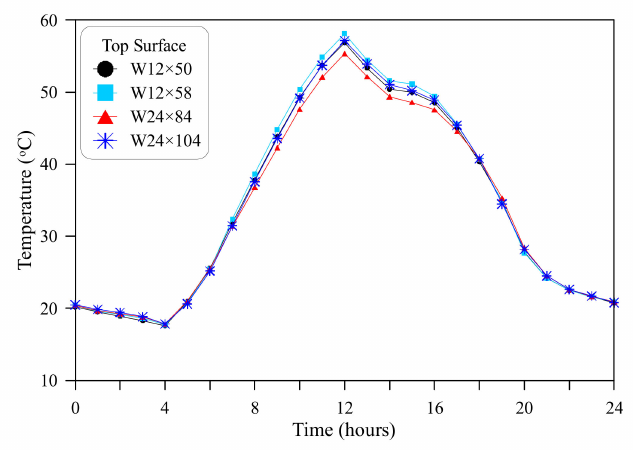
Figure 7. Temperature-time relations for the top surface of the steel sections.